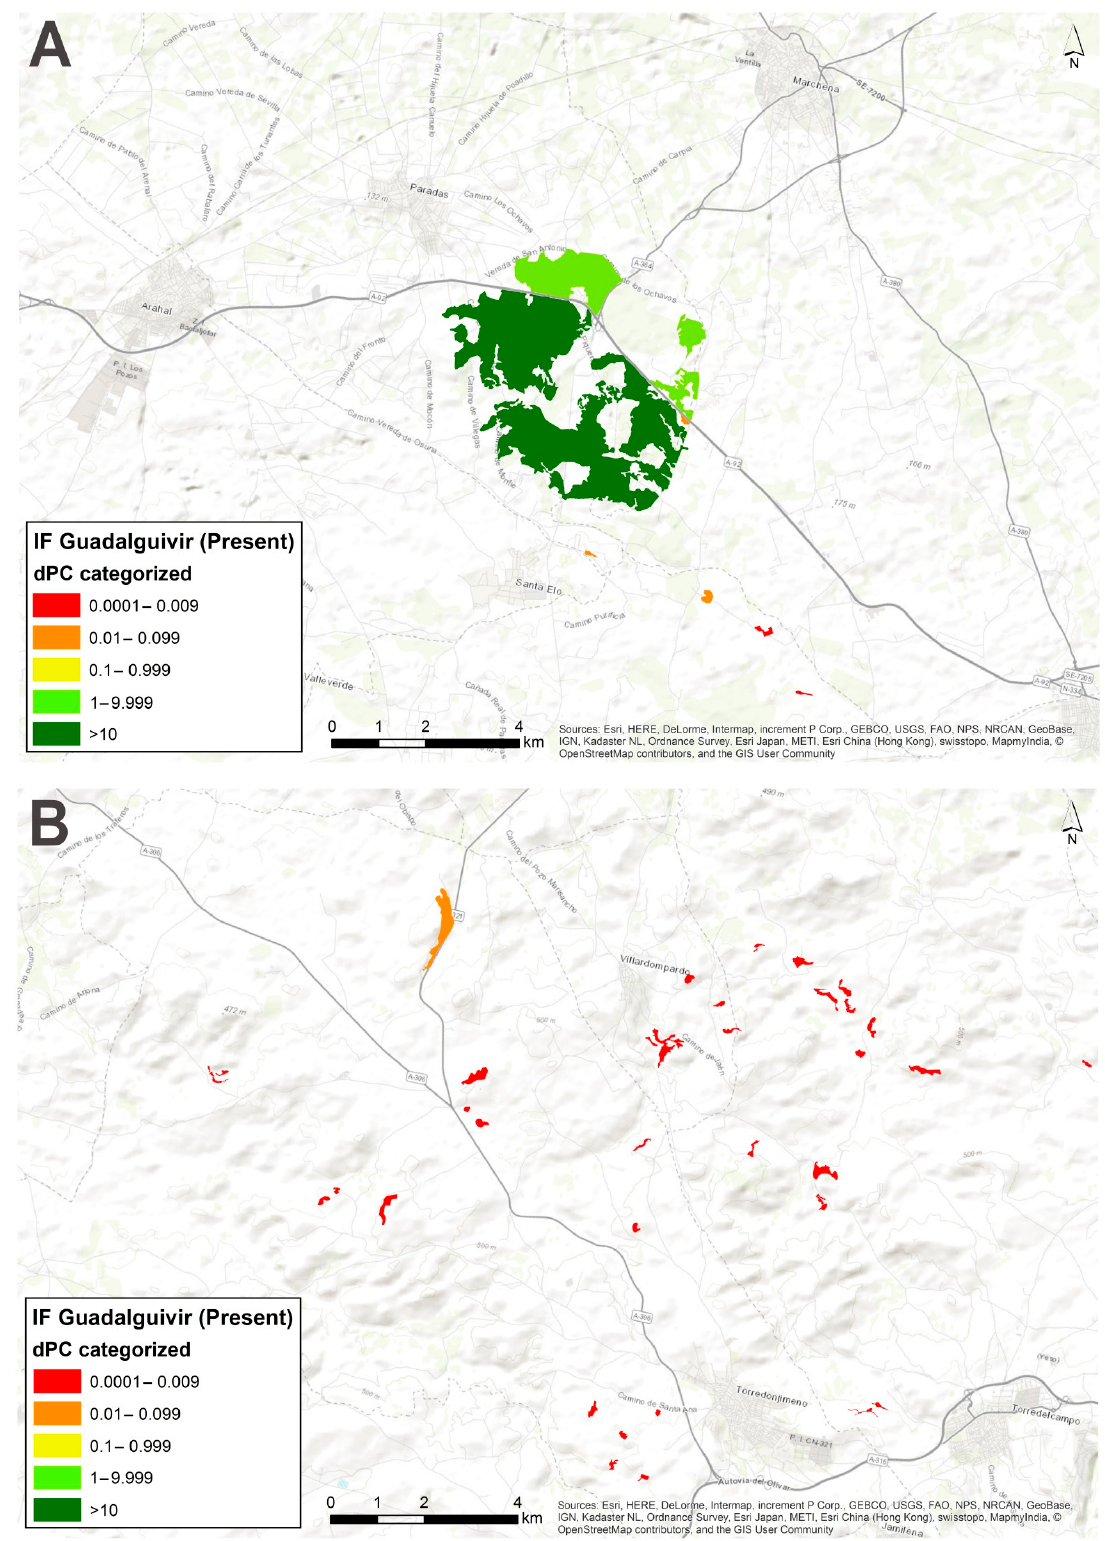
Figure 9. Two examples in the Guadalquivir valley. The IFs are standardized according to dPC values as described in Table 1. ( A ) shows a well-defined core habitat with high dPC value to the east of the village of Arahal (Seville, Spain). In ( B ) is a highly fragmented area in the surroundings of Villadonpardo (Jaen, Spain) with low–medium-low values of